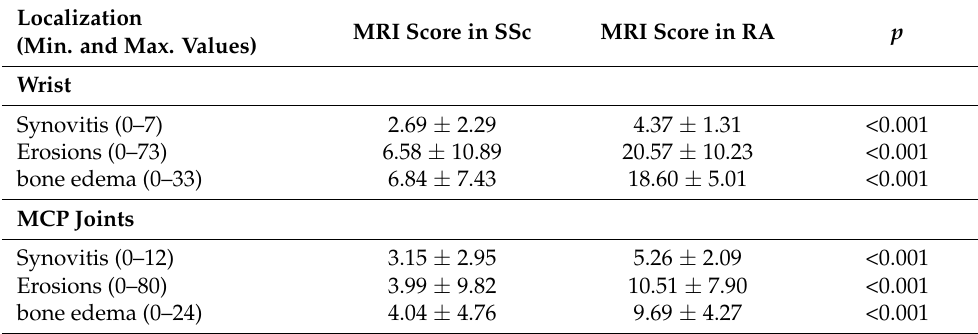
Table 4. Average values of total MRI score of synovitis, edema, and erosions in the wrist and MCP joints of dominant hand in SSc and